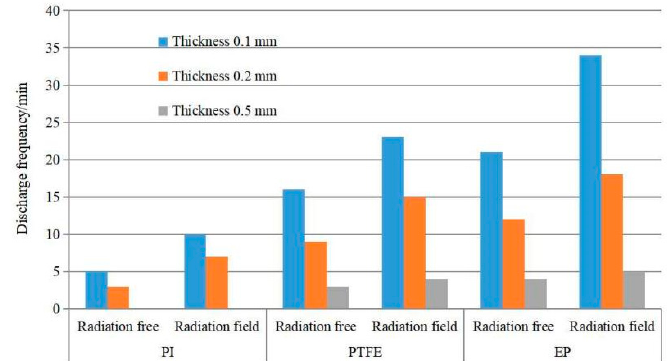
Figure 12. Comparison of the discharge of three materials with different thicknesses with or without external field irradiation.